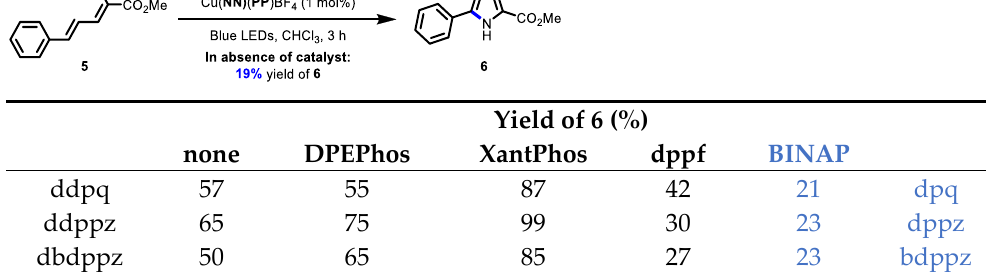
Figure 6. Comparison of the BINAP -containing copper complexes bearing π -extended ligands in an energy transfer process.